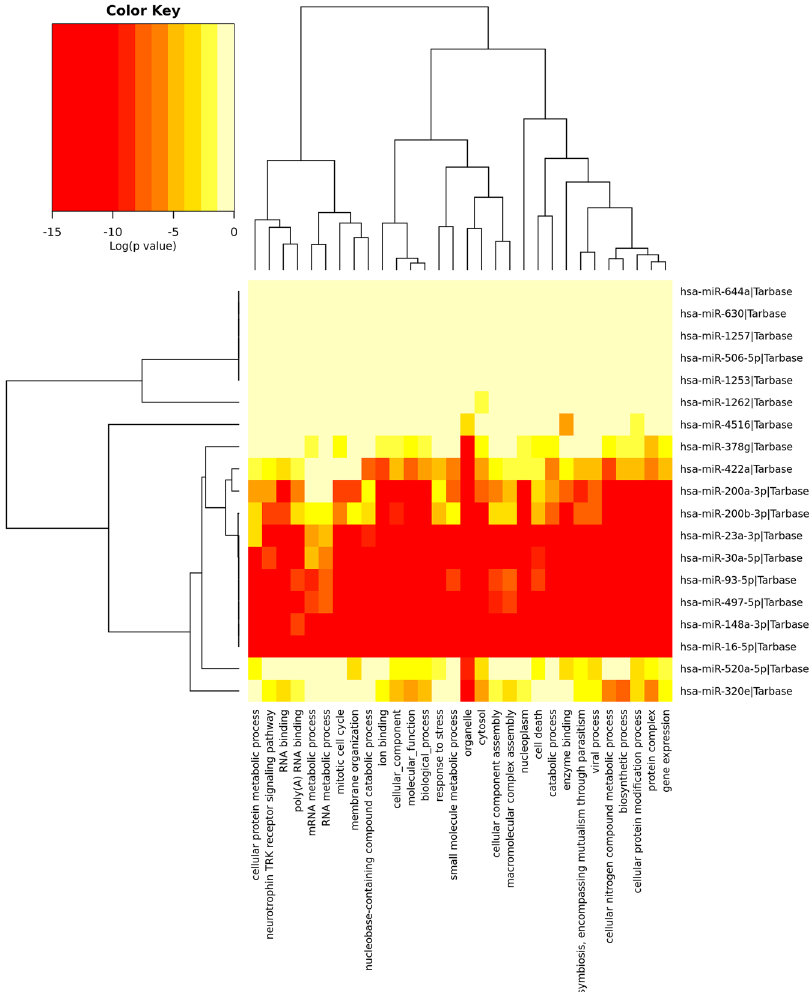
Figure 5. Gene Ontology Analysis of differentially expressed human milk exosome miRNAs. Gene Ontology of differentially expressed exosomal miRNAs in HIV-1 infected human milk is shown as heatmap which was created by DIANA-miRPath v3.0 software using Tarbase database. The heatmap enables similar miRNAs to cluster together in the same GO term. The color code represents the log ( P -value), with the most significant GO term in